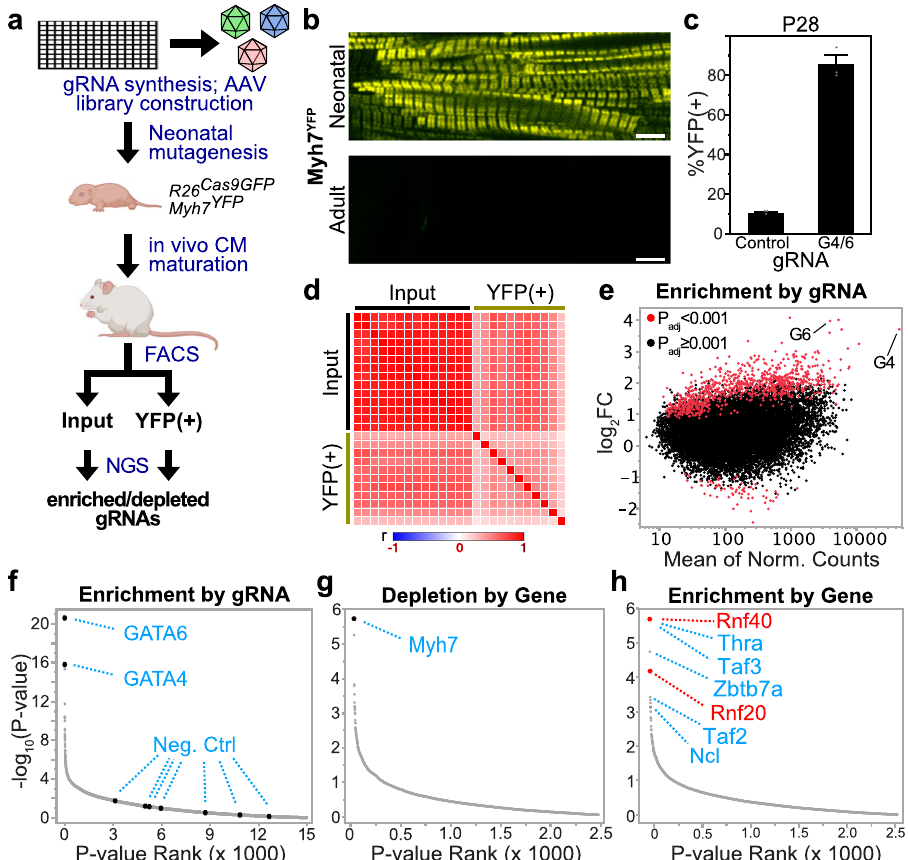
Fig. 1 High-throughput in vivo CRISPR – Cas9-based forward genetic screen for regulators of cardiomyocyte maturation. a Schematic overview of the screen design. On-chip oligonucleotide synthesis was used to generate a pooled AAV library containing ~15 k gRNAs that targeted transcriptional regulators. These were delivered to neonatal mice, and a fl ow cytometry (FACS)-based single-cell screening assay was used to identify immature CMs. Enriched and depleted guides were identi fi ed by next-generation sequencing (NGS) of gRNAs. Artwork from biorender.com. b Myh7 YFP expression is restricted to neonatal stage. Scale bars = 5 μ m; n = 5 mice. c Depletion of both GATA4 and GATA6 by CASAAV resulted in persistent MYH7 YFP expression. Data are presented as mean values + / − SEM. n = 3 mice per group. d Sample clustering by Pearson correlation ( r ). e DESeq2 differential expression analysis of individual gRNAs. Red dots are gRNAs with Benjamini – Hochberg corrected Wald test p -value < 0.001. GATA4 P = 1.5 × 10 − 16 , GATA6 P = 2.4 × 10 − 21 . f Enrichment of positive (GATA4/6) and negative control gRNAs within YFP + CMs as calculated by DESeq2. g Gene depletion as calculated by MAGeCK. h Gene enrichment as calculated by